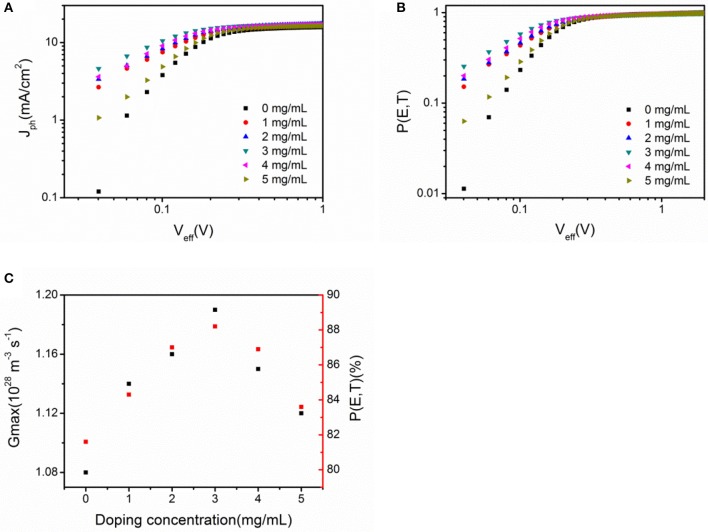
(A) Photocurrent density (Jph) as a function of the effective voltage (Veff). (B) Exciton dissociation probability P (E, T) as a function of the effective voltage. (C) The values of Gmax and P (E, T) obtained for inverted PSCs using U-ZnO as the ETL. All PSCs have an identical configuration of ITO/ETL(40 nm)/PTB7:PC71BM(95 nm)/MoO3(5 nm)/Al(80 nm).